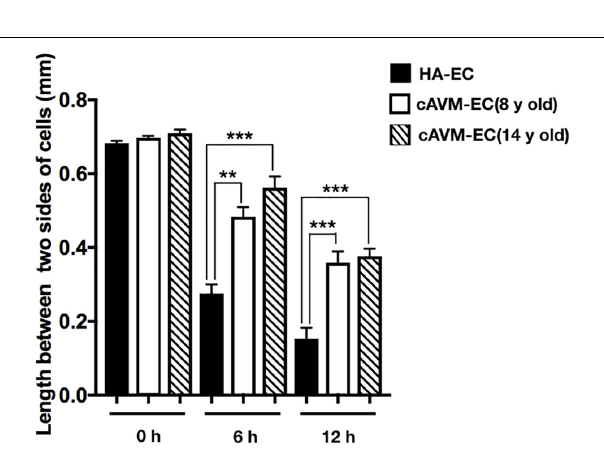
FIGURE 6 | Statistical analysis of scratch assay in cAVM-ECs and HA-ECs. After 6 h, the distances between two sides of scratch in HA-ECs were (0.276 ± 0.024) mm, (0.483 ± 0.026) mm in cAVM-ECs of 8-year-old, and (0.563 ± 0.030) mm in cAVM-ECs of 14-year-old (all ∗ p < 0.05). After 12 h, the distances between two sides of scratch in HA-ECs were (0.153 ± 0.029) mm, (0.359 ± 0.030) mm in cAVM-ECs of 8-year-old, (0.376 ± 0.021) mm in and cAVM-ECs of 14-year-old (all ∗ p < 0.05). Besides, the distances between two sides of scratch in cAVM of 8- and 14-year-old patients had no significant difference.